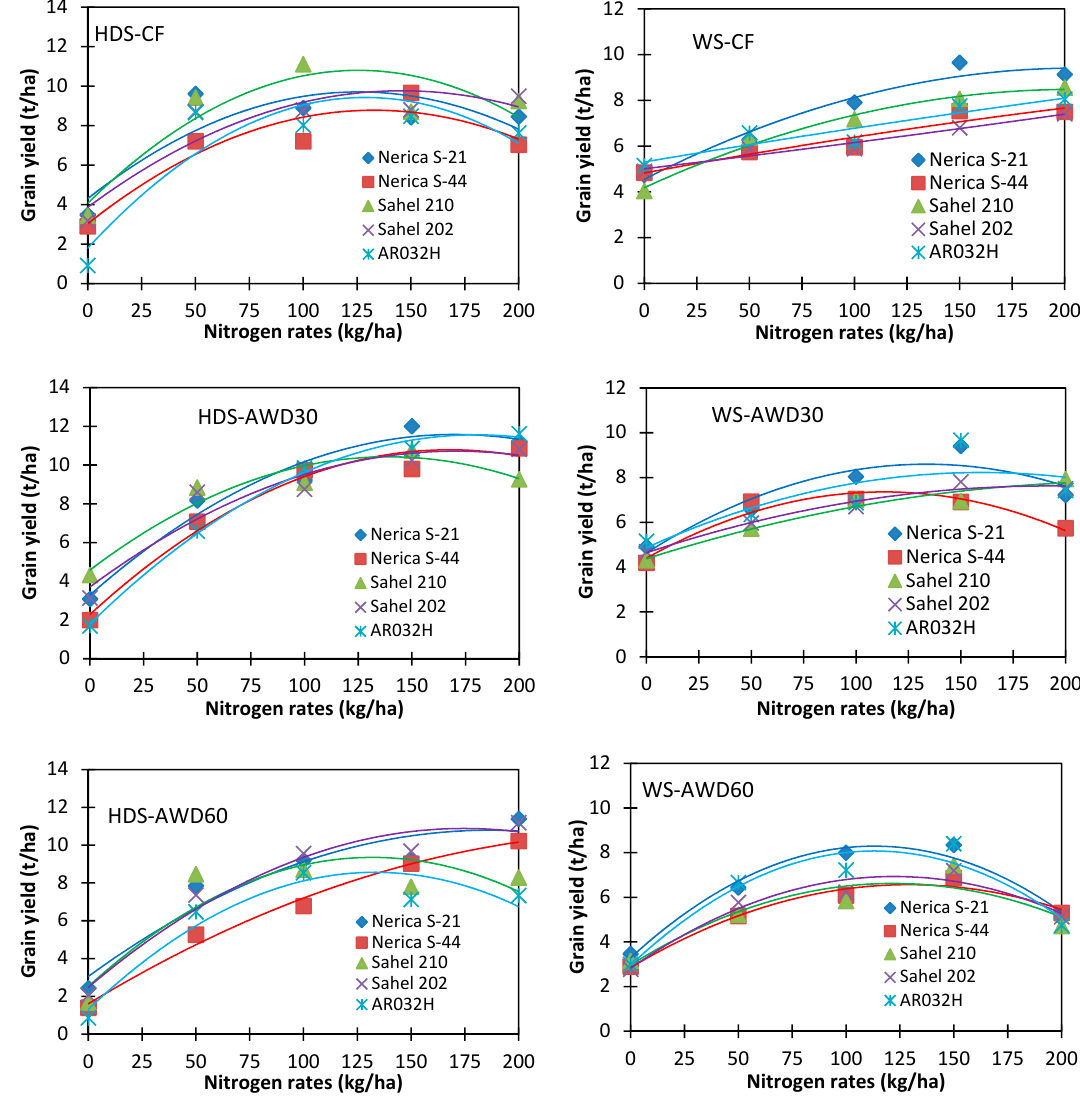
Figure 3. Relationships between the applied nitrogen rates and the paddy yield of five rice genotypes in the HDS and WS 2015.